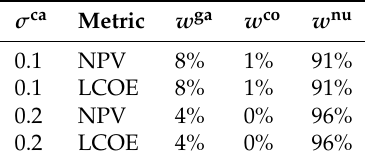
Table 13. The composition of minimum variance portfolios: The three-asset